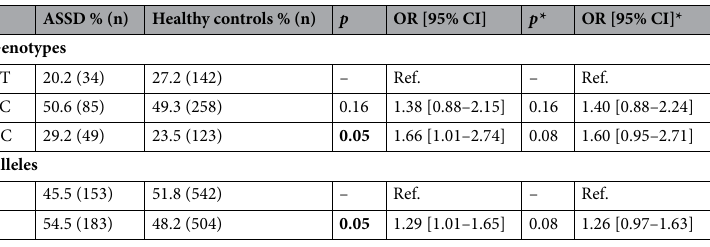
Table 1. Genotype and allele frequencies of MUC1 rs4072037 in ASSD patients and healthy controls. ASSD: antisynthetase syndrome; CI: confidence interval; OR: odds ratio. *Adjusted for age and